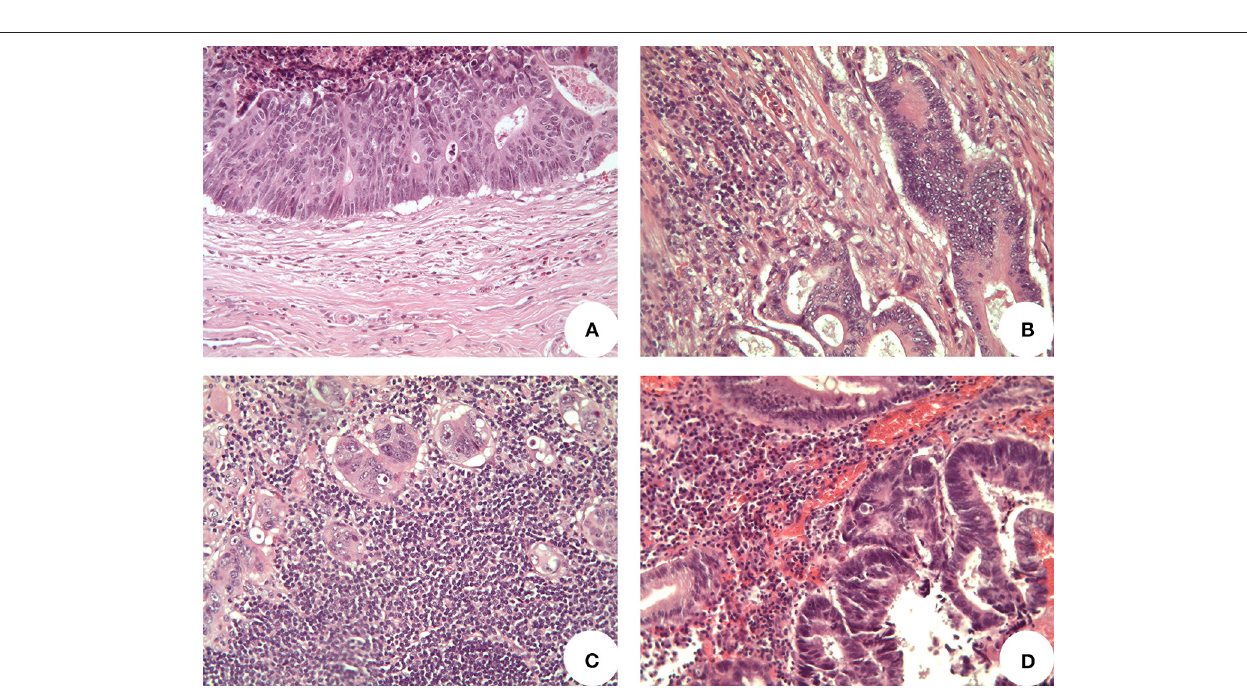
FIGURE 1 | Histopathological features associated with lymph node metastasis in pT1 colorectal cancer (CRC). (A) High-grade tumor budding represented by equal or more than five clusters of less than five tumor cells at the invasive front of the tumor (black arrows) (original magnification: 200X); (B) Tumor cells invasion of peritumoral stromal vessels representing lymphovascular invasion (original magnification: 100X); (C) Absent/mild tumor-infiltrating lymphocytes surrounding tumor cells (original magnification: 100X); (D) High tumor-infiltrating lymphocytes facing the invasive tumor front (original magnification: 100X).